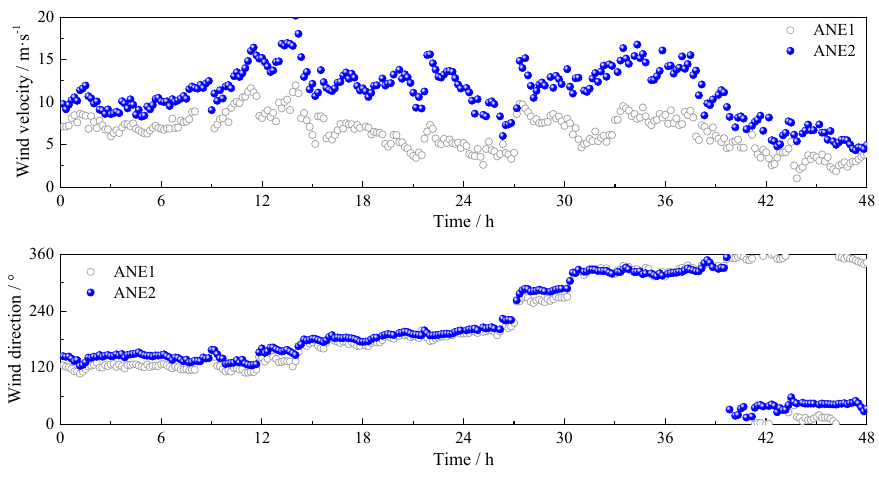
Figure 4. Comparison of the wind samples from ANE1 and ANE2.